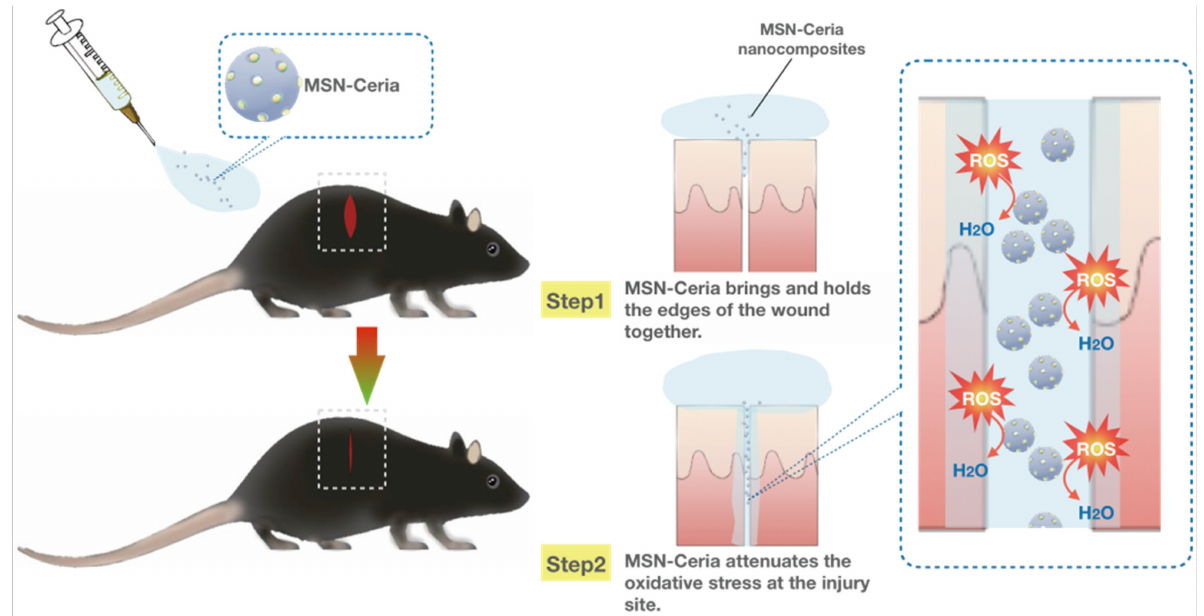
Figure 5. MSN-Ceria as a ROS-scavenging tissue adhesive nanocomposite in wound healing. MSN-Ceria carries both adhesion properties and ROS-scavenging potential. MSN-Ceria holds the edges of the wound together, followed by the attenuation of ROS generation at the injury site, leading to enhanced skin wound